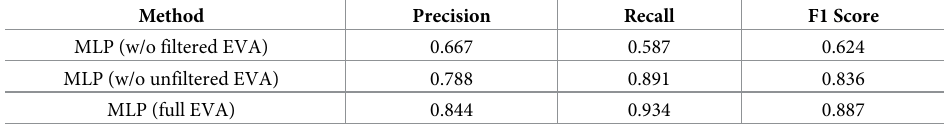
Table 5. A table of ablation test results on the information value contributions to the predictive utility of EVA features on DEEP journals. Unfiltered EVA features have comparably less information value to filtered EVA features.